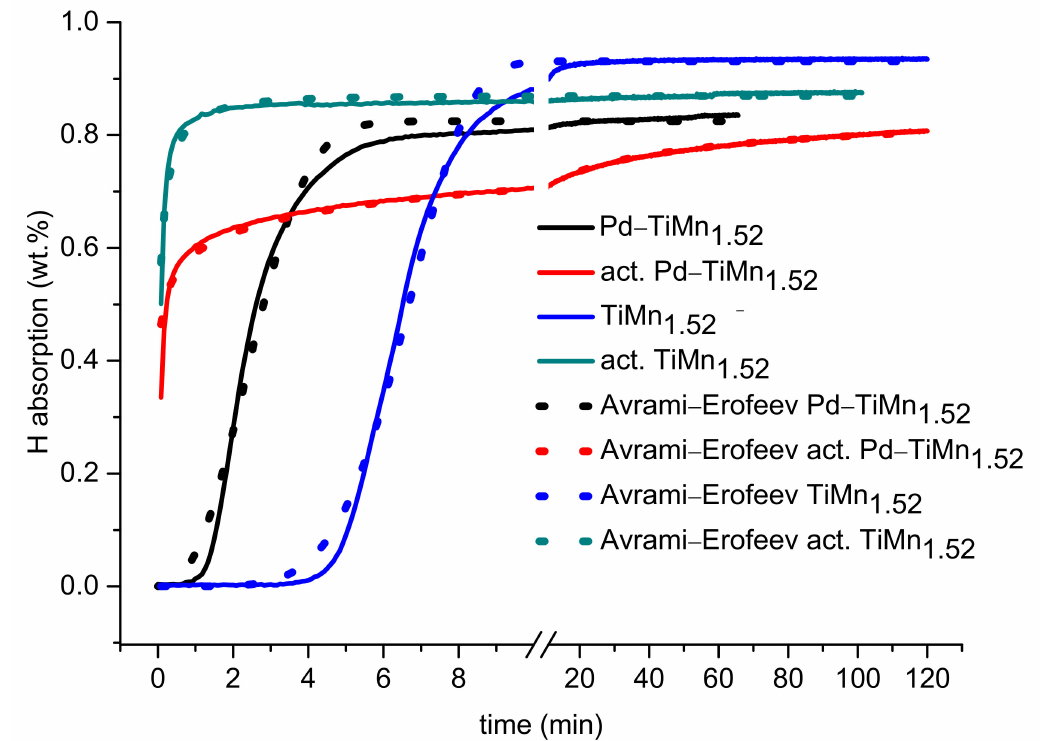
Figure 4. Dynamics of hydrogen absorption (T = 20 ◦ C, P H2 = 30 bar) by uncoated and Pd-coated AB 2 alloys after pre-exposure to air and after preliminary activation (vacuum